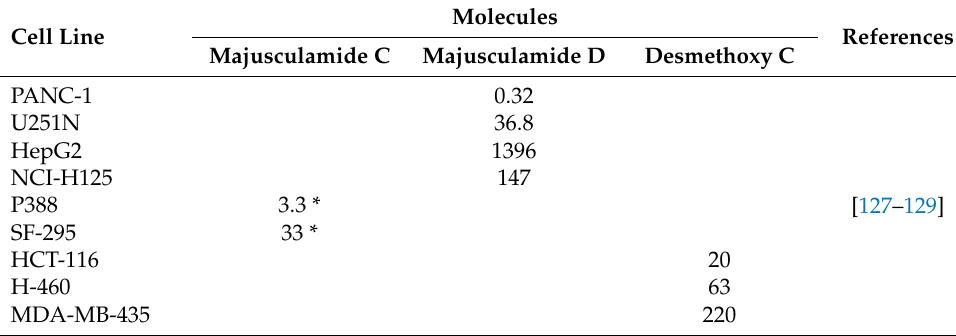
Table 10. Majusculamide analog activities on cancer cell lines.